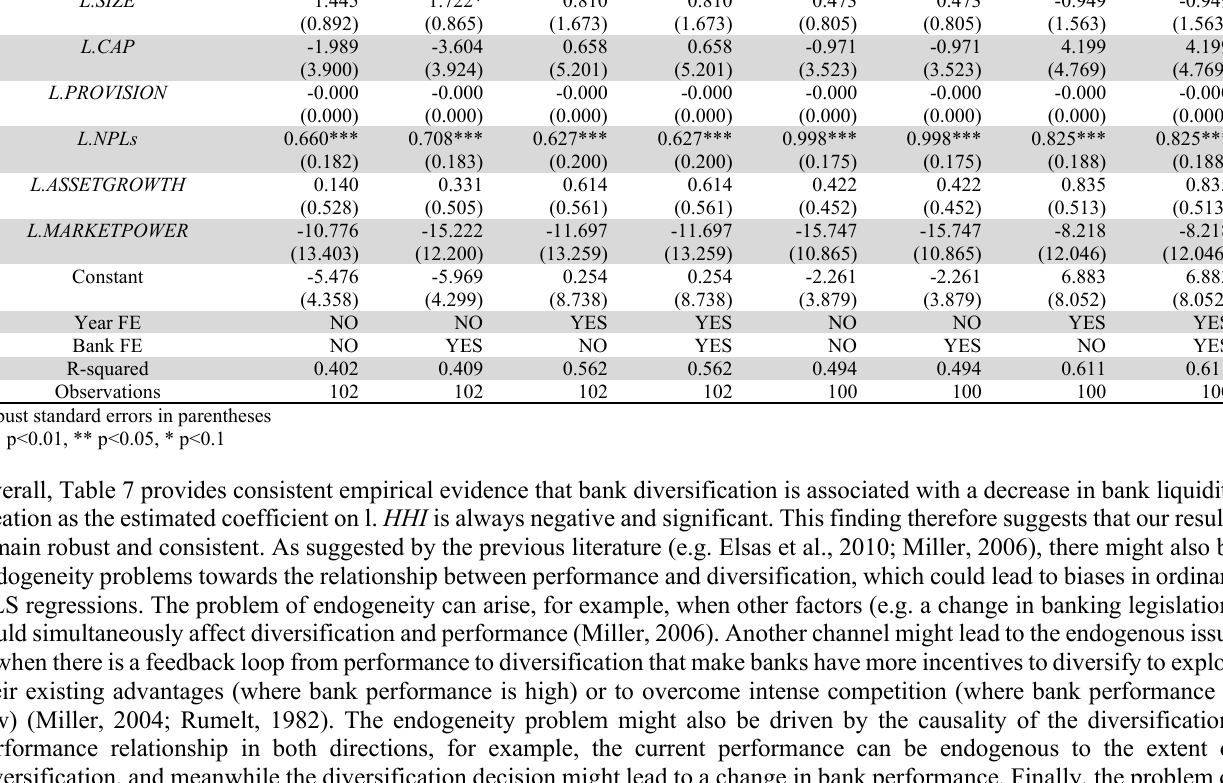
Robust standard errors in